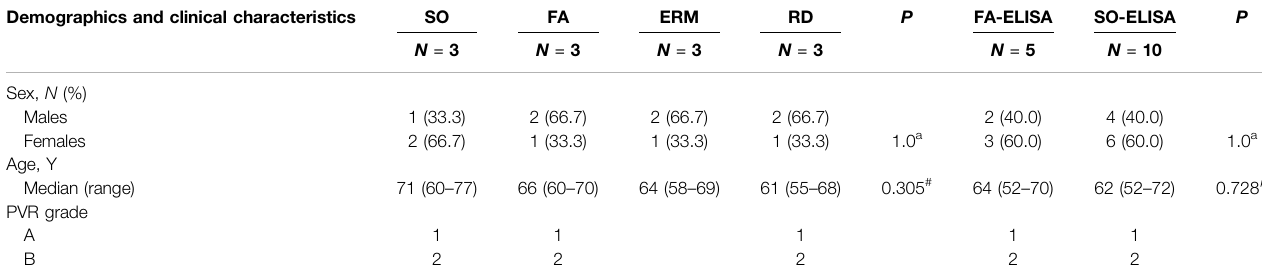
TABLE 1 | Demographics and clinical characteristics of the study population. Demographics and clinical characteristics